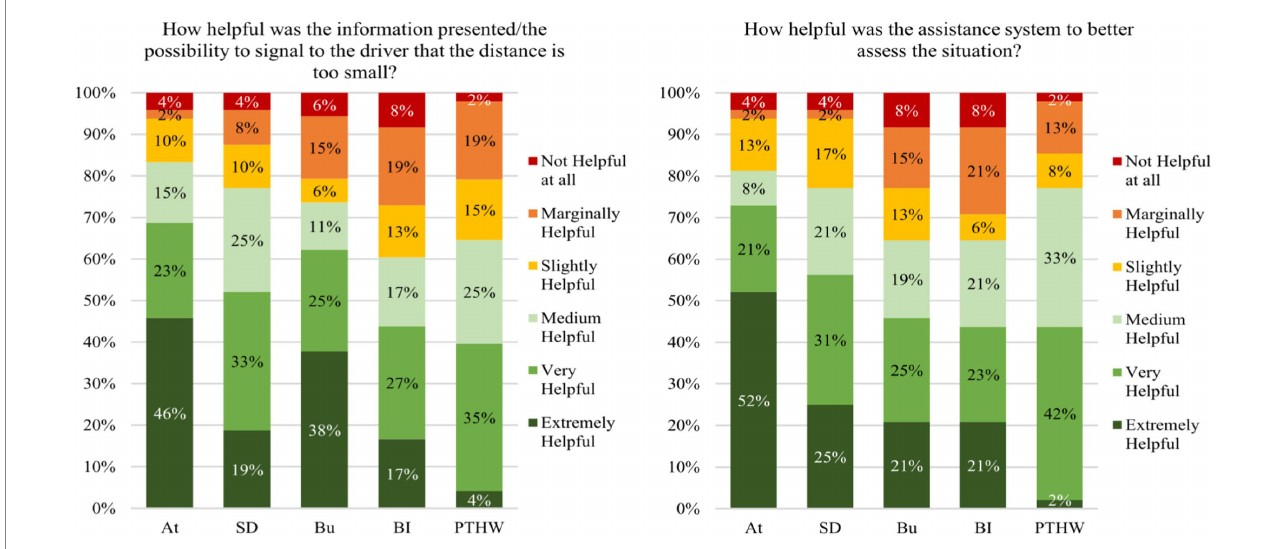
FIGURE 10 Distribution of scenario specific ratings regarding (left) the helpfulness of the present information, respectively, the possibility to have influence, and (right) the helpfulness of the assistance system to better assess the scenarios